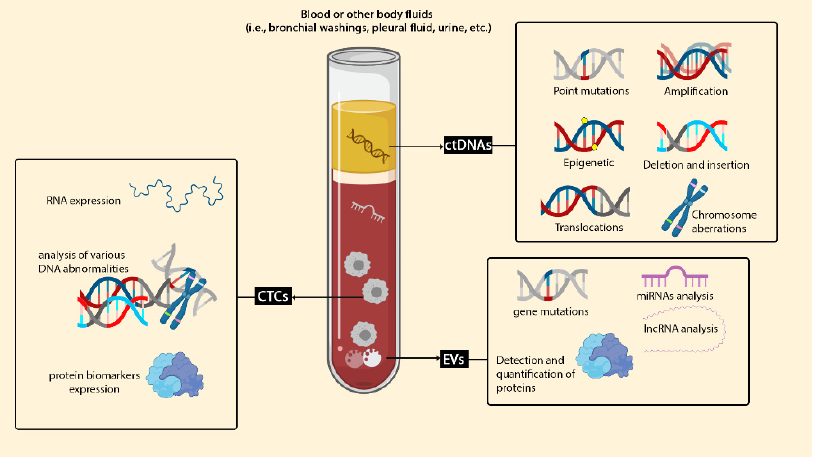
Figure 2. Liquid biopsy in lung cancer. Liquid biopsy can be considered for plenty of clinical targets. Liquid biopsy biomarkers are categorised into three main groups: circulating free DNA (cfDNA), CTCs and EVs. cDNA can be used for detecting a wide variety of mutations, such as insertions, deletions and amplification. Capturing and identifying CTCs in whole blood are cooperative for checking proteins and RNA expression and analysing various DNA abnormalities.